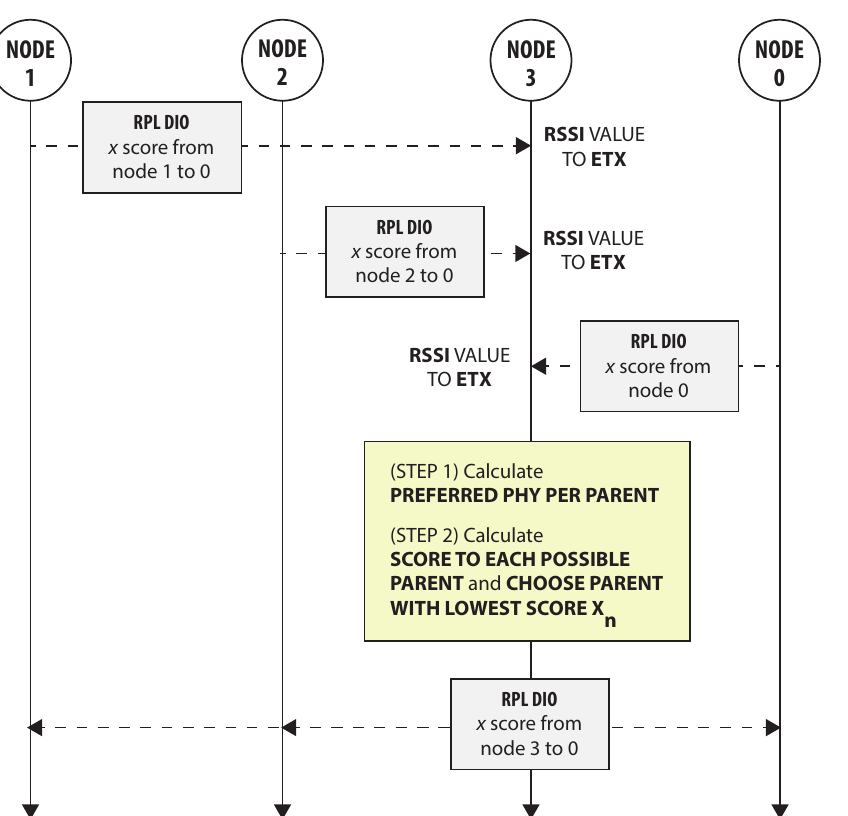
Figure 3. Illustration of the distributed implementation of the heuristic in the RPL routing layer. Node 3 uses the heuristic to select a new PHY and parent, by using the received x scores to the root node 0 and the new reliability values (based on the calculated RSSI values). After calculating the lowest possible x score from node 3 to node 0 (and thus also selecting its preferred parent and PHY), this score is broadcast throughout the network. Normally, all RPL DIO messages are broadcast to all nodes, but this is omitted for node 0, 1 and 2 to make the figure